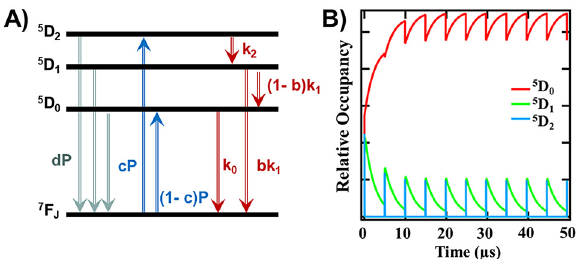
Figure 13: (A) The Eu 3 + energy levels and transitions used in the simulation. The light arrows indicate back-transfer; the blue arrows indicate excitation, and the red arrows represent the radiative and nonradiative transitions. (B) Simulation of the 5 D 0 , 5 D 1 and 5 D 2 state time evolution under high pulse intensity and high repetition